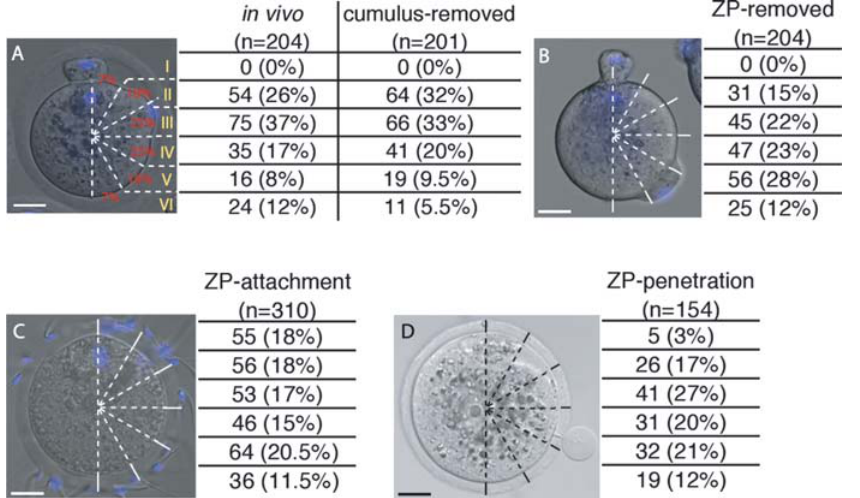
Figure 1. The MII Oocyte Is Preferentially Fertilized in the pb Half Sphere Independent of Intrinsic Polarity (A) Distribution of the site of fertilization with respect to the 2pb in vivo and in vitro after cumulus cell removal. Zones I–VI (depicted in yellow), defined as 30 8 wide each, categorize the site of fertilization with respect to the 2pb. The proportion of the surface area for each zone is depicted in red. (B) Distribution of the position of fertilization in vitro after zona pellucida removal. (C) Distribution of sperm binding to defined regions of the ZP with respect to the meiotic chromosomes at MII stage. (D) Distribution of the point of ZP penetration by the sperm with respect to the 2pb. Results are all presented in the order of Zone I to VI. Scale bars represent 20 l m. DOI: